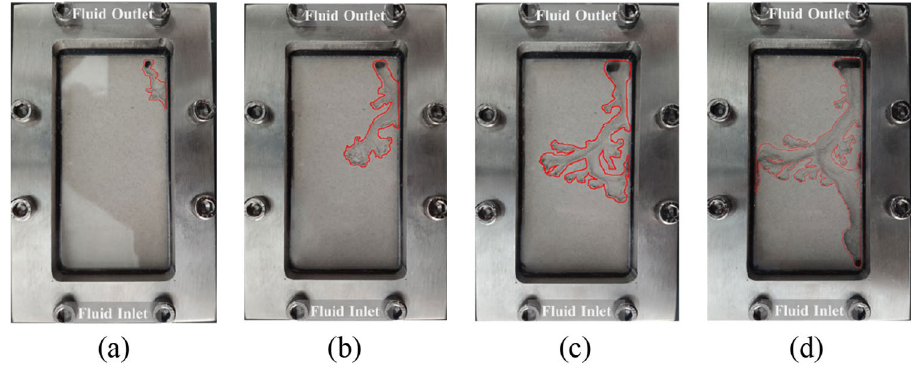
Fig. 9 The macroscopic extending performance of the sanding cav- ity of the multi-branch wormhole. a The performance of the sanding cavity after the 38th second with total pressure drop 11.6 kPa; b the performance of the sanding cavity after the 128th second with total